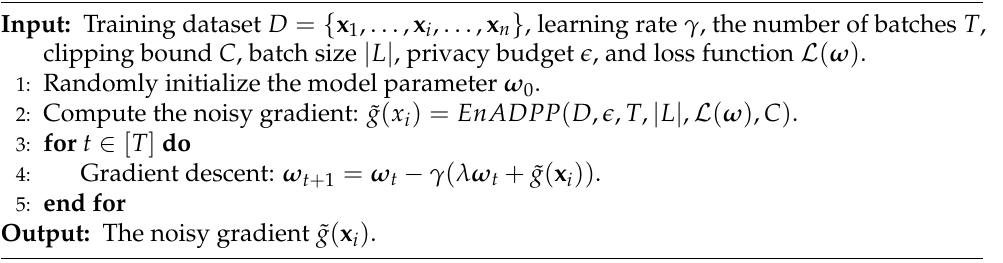
Algorithm 2 Adaptive differential privacy SGD optimization